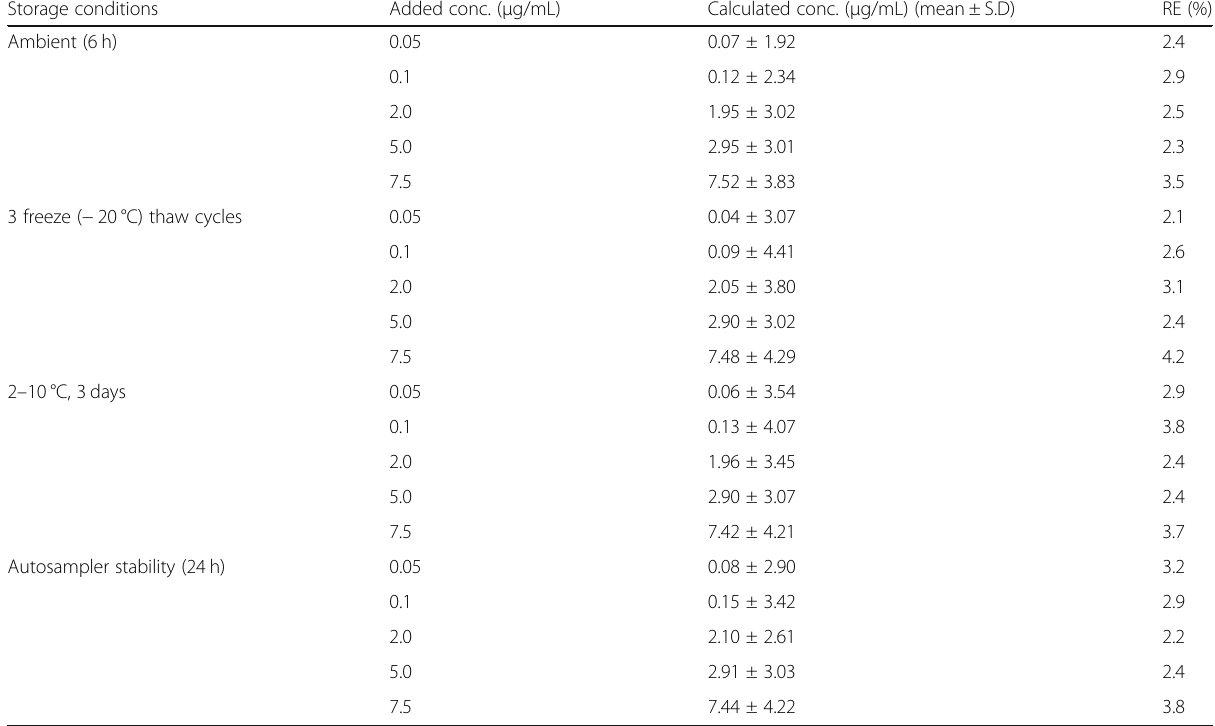
Table 4 Stability data of daclatasvir from rat serum Storage conditions